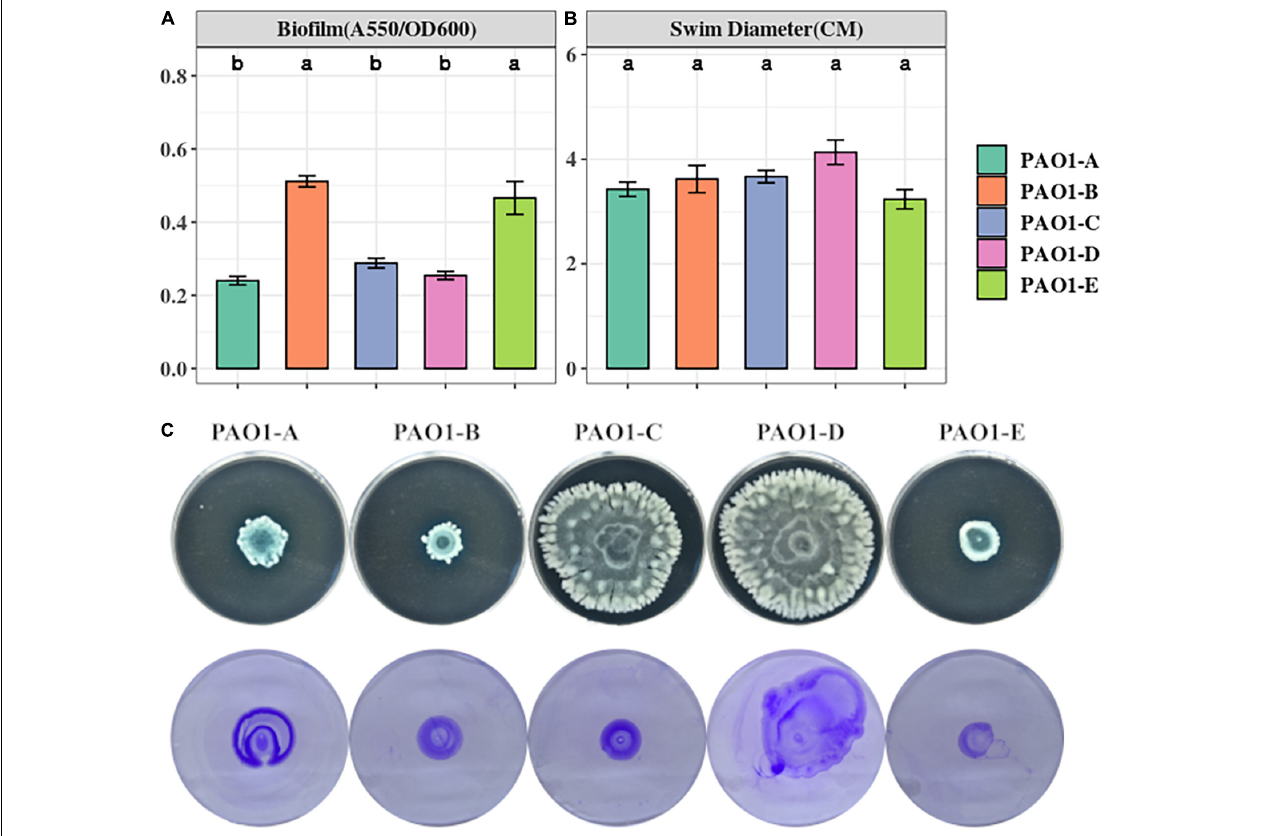
FIGURE 3 | Venn diagram showing the SNPs shared among the P. aeruginosa PAO1 sublines.